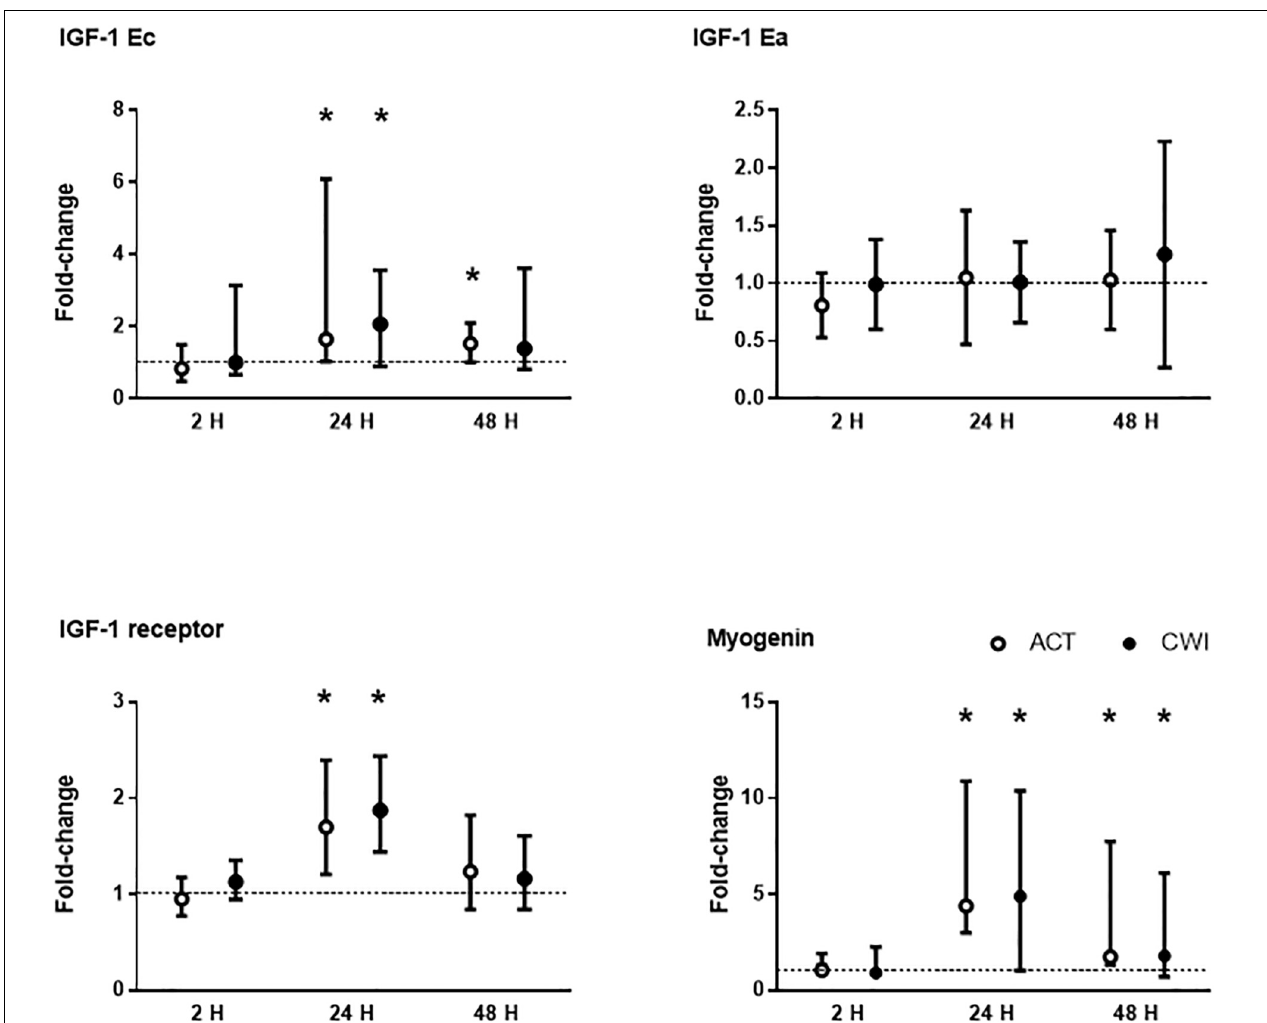
FIGURE 1 | Post-exercise changes in mRNA expression of insulin-like growth factor (IGF)-1 splice variants IGF-1 Ea and IGF-1 Ec (mechano growth factor), IGF-1 receptor and myogenin. Data are presented as changes in the mean ± SD for IGF-1 Ea, and the median ± interquartile range for IGF-1 Ec, IGF-1 receptor and myogenin. * P < 0.05 versus pre-exercise. ACT, active recovery; CWI, cold water immersion. The dotted line represents a nominal pre-exercise value of 1.0 (for comparison).